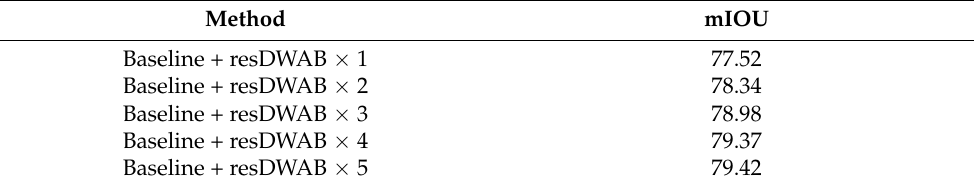
Table 4. Detailed Performance of Our Model with Different resDWAB